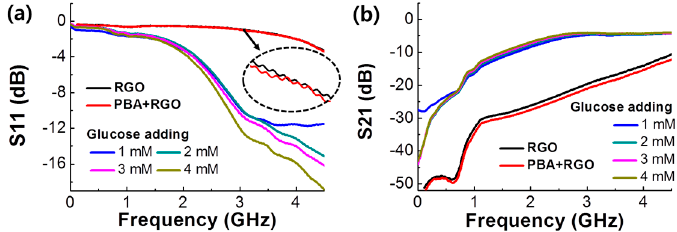
Figure 4. Up to 4.5 GHz, RF measurement result of RGO and PBA/RGO RF device. ( a ) Signal reflection (signal from port 1 to port 1, S11) and ( b ) transmission (signal from port 1 to port 2, S21). Glucose solution (3 μ L) from 1 to 4 mM was dropped on the central position of the PBA/RGO device.